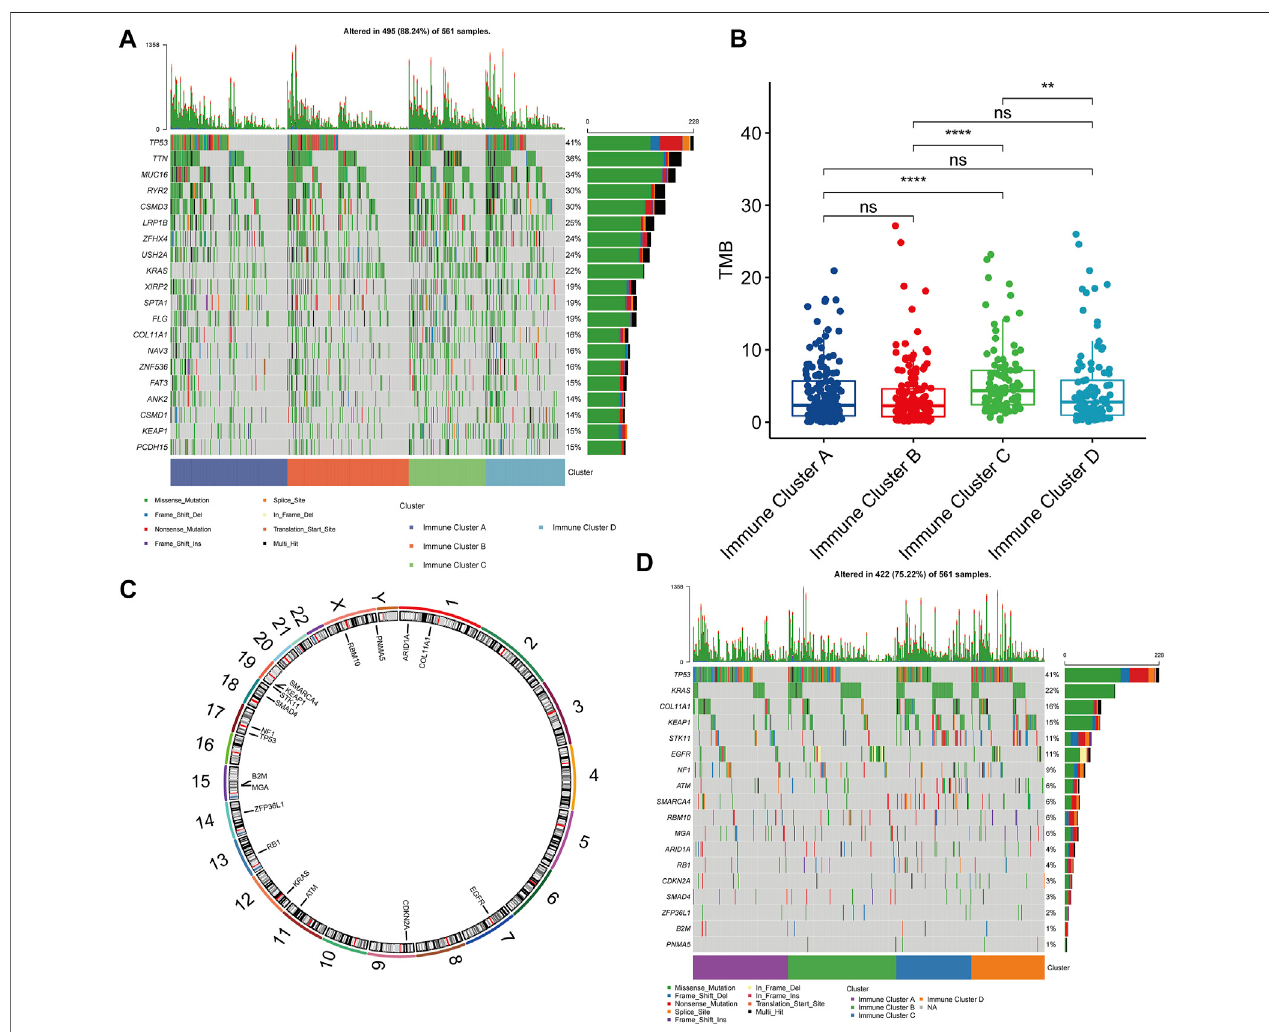
FIGURE6| GeneMutationLandscapesinPatientswithDifferentClusters. (A) Top20genesinmutationfrequencyinallclusters. (B) Comparisonoftumormutation burdenindifferent clusters. (C) Chromosomal localization oftumor drivermutatedgenesidenti fi edbyMutSigCValgorithm. (D) Distribution oftumor drivermutant genes in